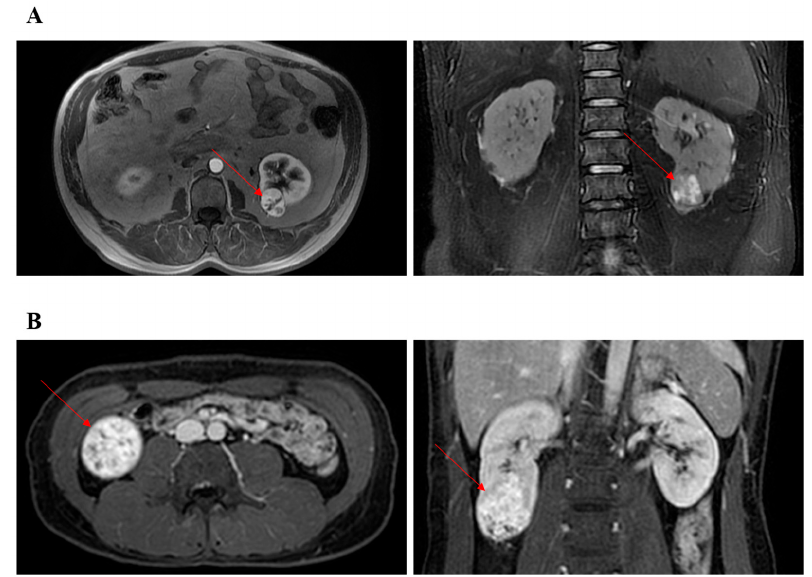
Figure 1. Representative images of CT or MRI. Red arrow points to renal tumor. ( A ) The patient underwent retroperitoneal robotic partial nephrectomy. ( B ) The patient underwent transperitoneal robotic partial nephrectomy.